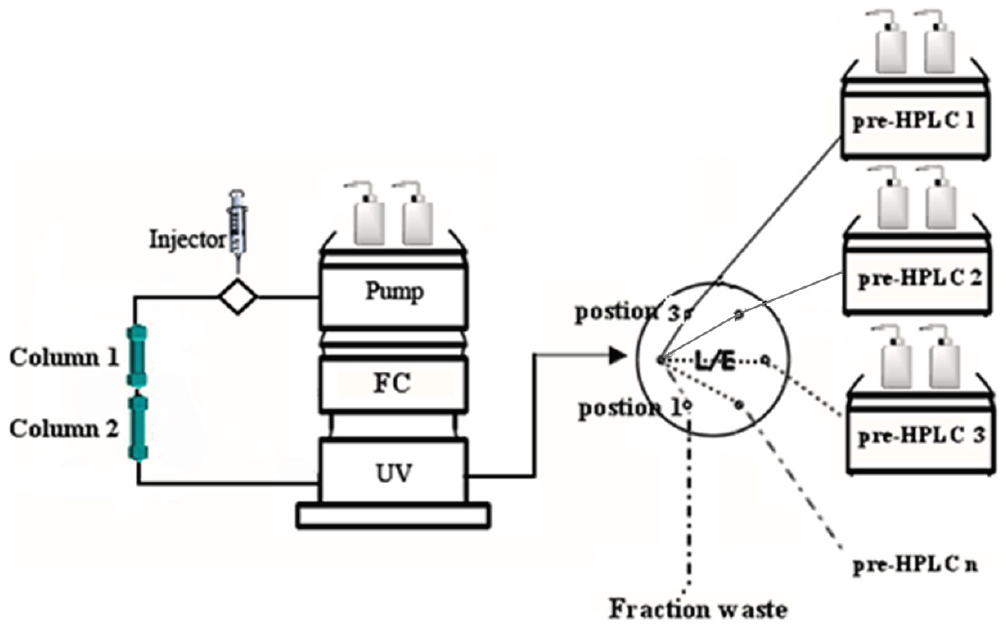
Figure 1. Diagram of flash chromatography coupled with multiple preparative high performance liquid chromatography. FC (flash